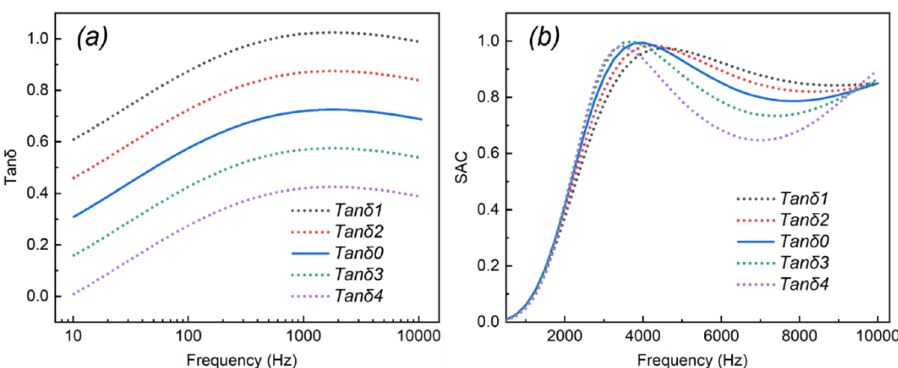
Figure 4. ( a ) Different tan δ settings with gradient. ( b ) The SAC results of the PU ‐ based composite with different tan δ .